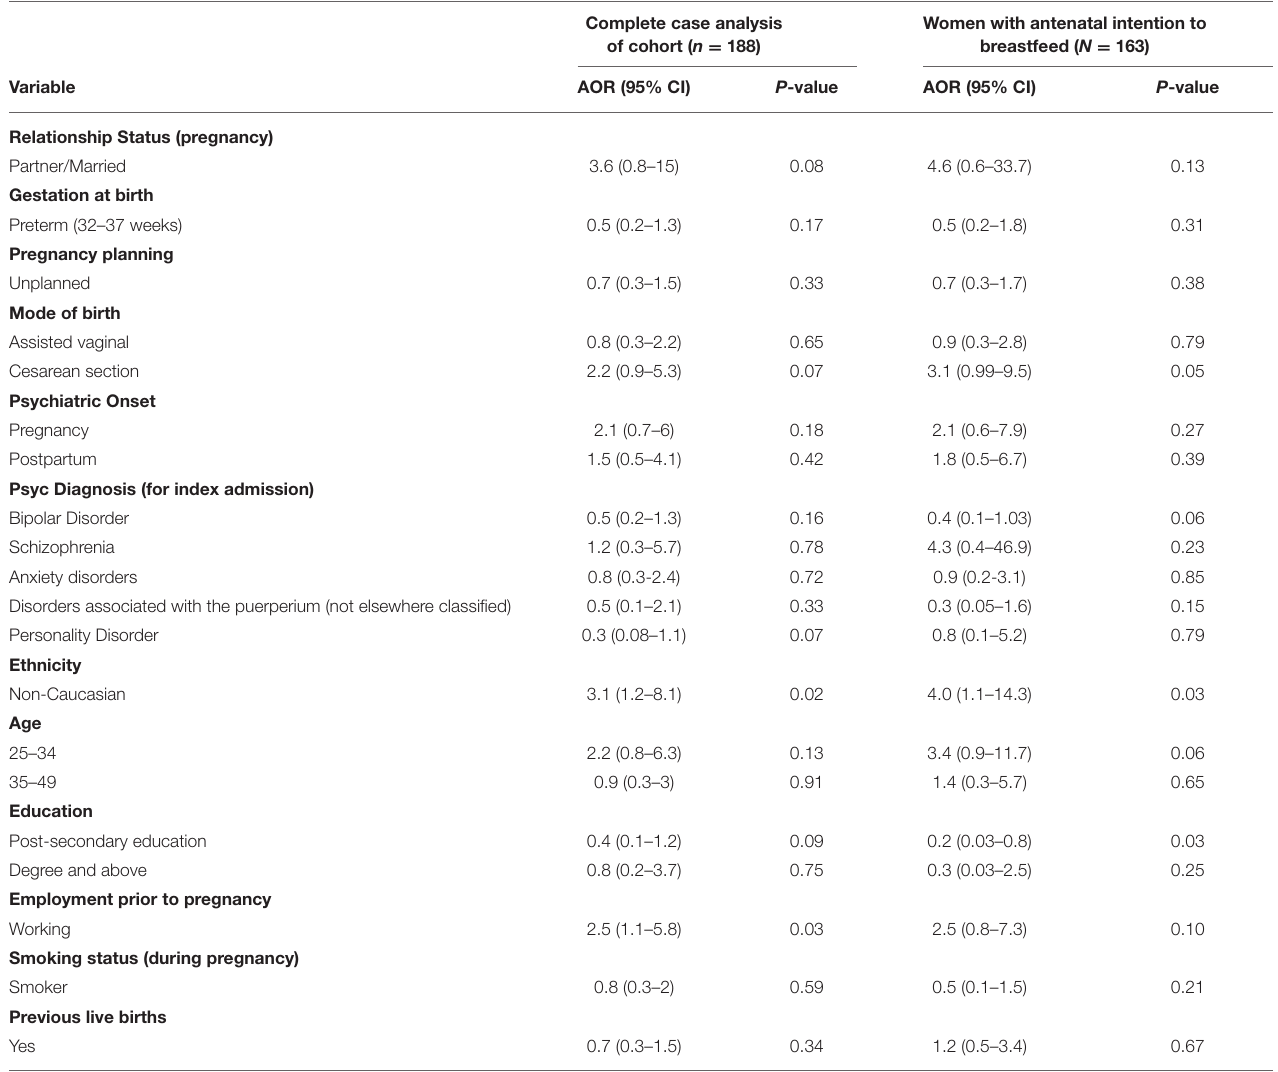
TABLE 2 | Characteristics associated with breastfeeding in women with